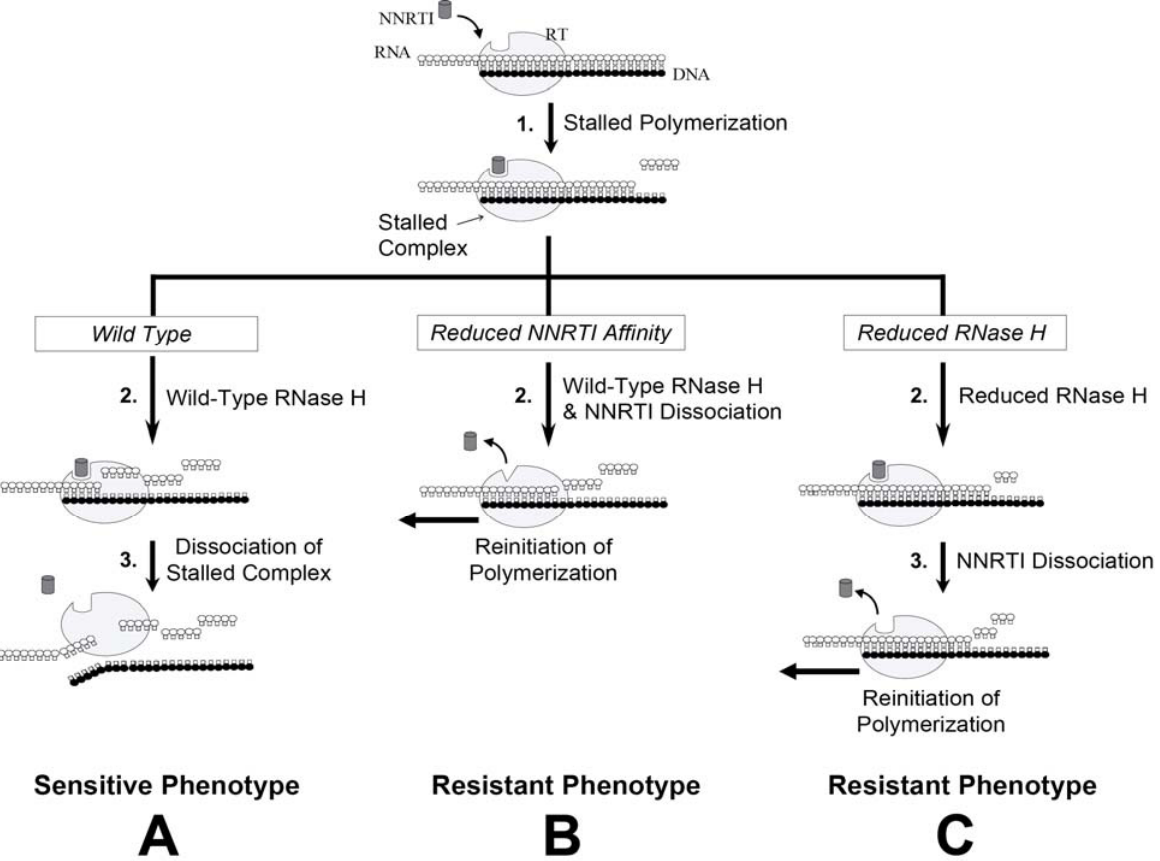
Figure 4. Mechanism of C-terminal domain NNRTI resistance. During